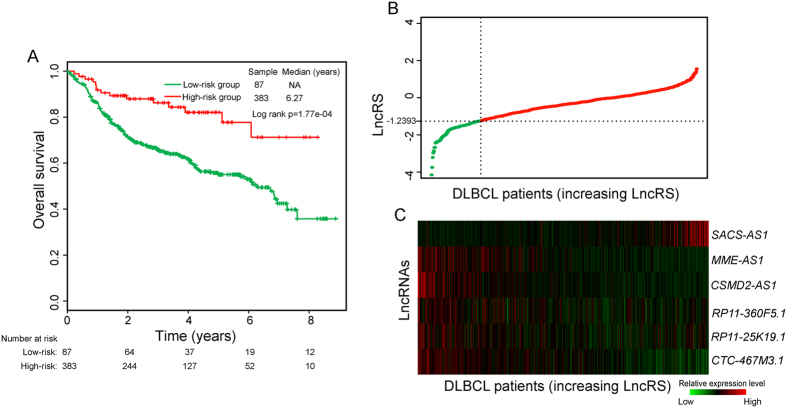
Independent confirmation of the six-lncRNA signature using an additional dataset of 470 patients.(A) Kaplan–Meier survival curves for patients in the Visco dataset. (B) The LncRS distribution of patients in the Visco dataset. (C) The expression heatmap of six prognostic lncRNAs in the 470 patients of Visco dataset.